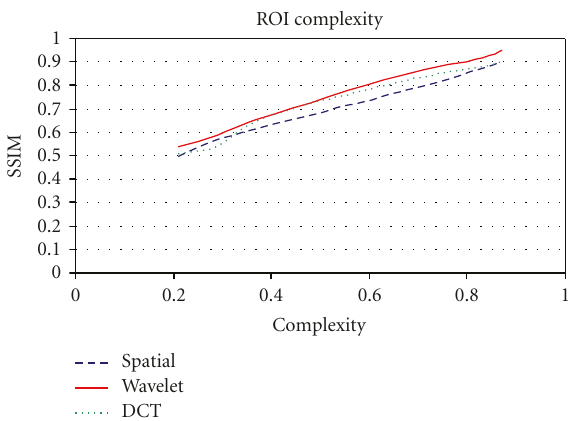
Figure 6: Relation between SSIM and ROI complexity measure (averaged on 2000 images).